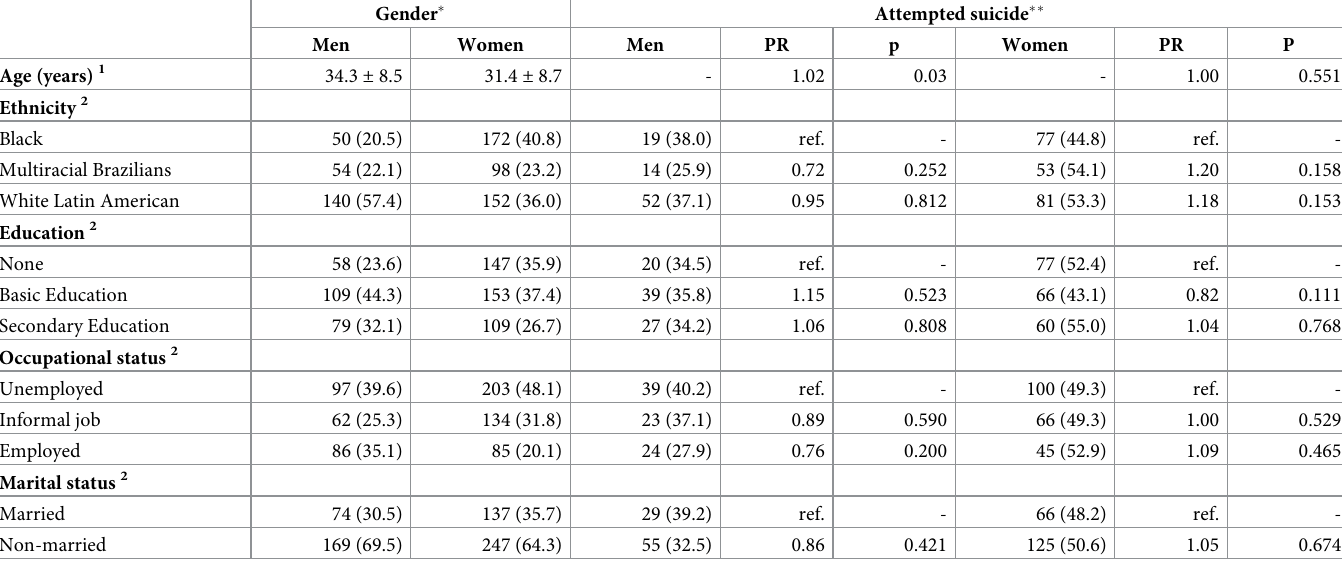
Table 1. Sociodemographic variables and prevalence ratios (PR) for attempted suicide, stratified by